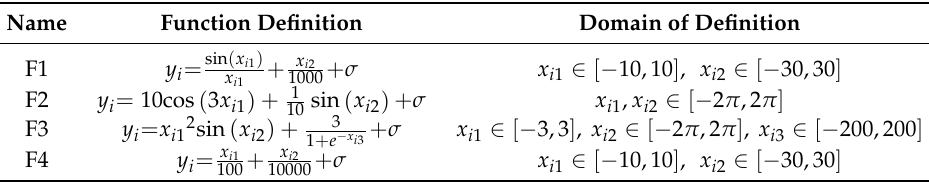
Table 2. Functions used to generate synthetic datasets.